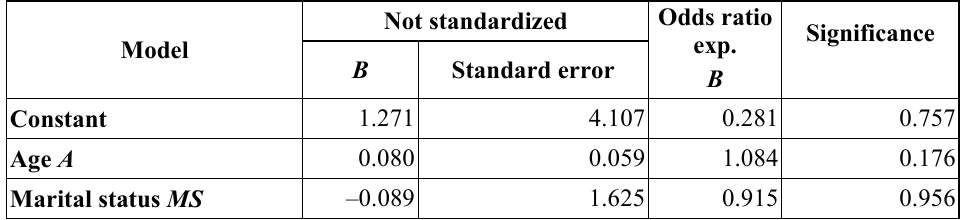
Table 5. Logistics Regression Analysis for Disciplinary Penalty